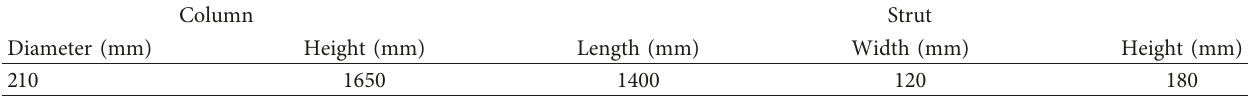
Table 1: Frame dimensions.